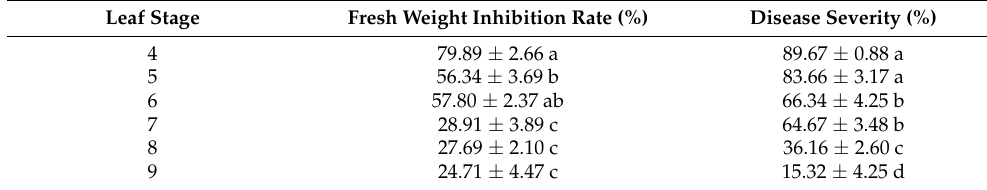
Table 4. Efficacy of C. echinochloae B-48 in controlling barnyardgrass at different growth stages. Leaf